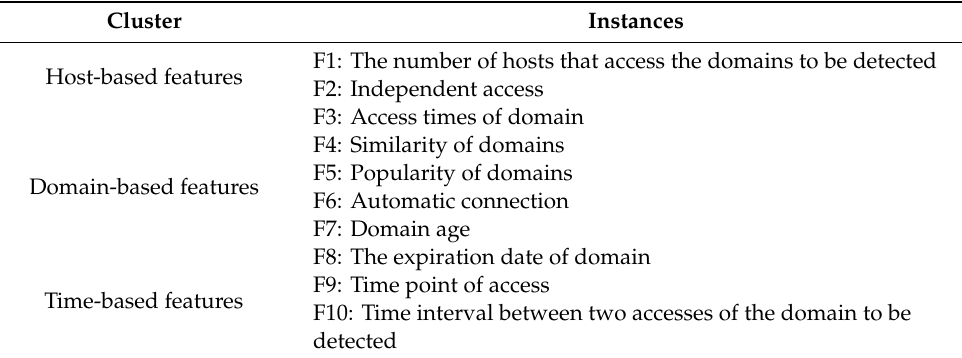
Table 2. Feature